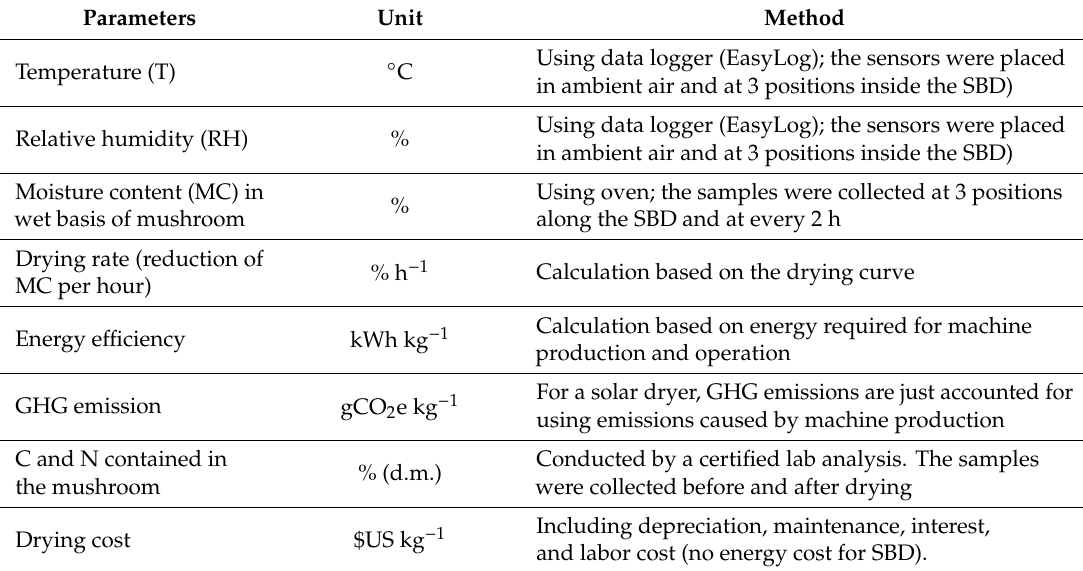
Table 1. The parameters included in the investigation of mushroom drying.